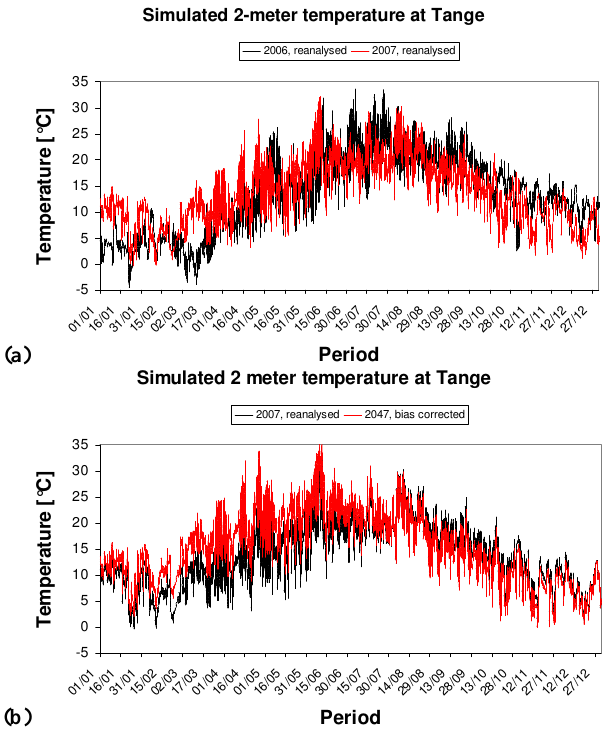
Fig. A1. (a) The hourly variation in simulated 2-m temperature for the Tange area that was used in the paper by Skjøth et al. (2011) and correspondingly hourly variations for the year 2006 using an identical model setup. (b) The hourly variation in simulated 2-m temperature for the Tange area that was used in the paper by Skjøth et al. (2011) and the simulated future variation on 2-m temperature using climate model output from the ENSEMBLES data set and bias